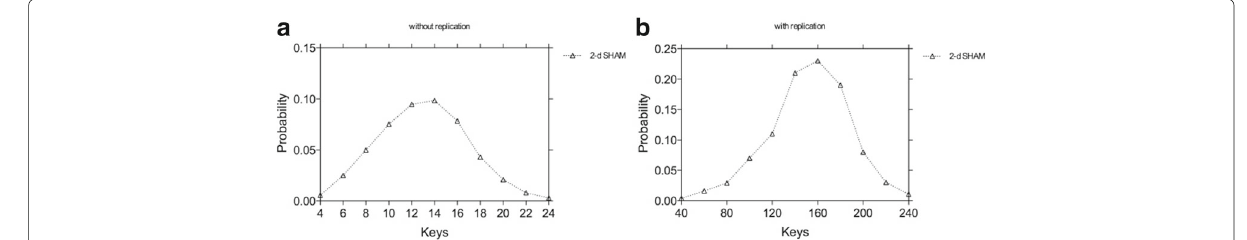
Fig. 12 Distribution of 2 14 keys over 2 12 nodes. a Without replication. b With